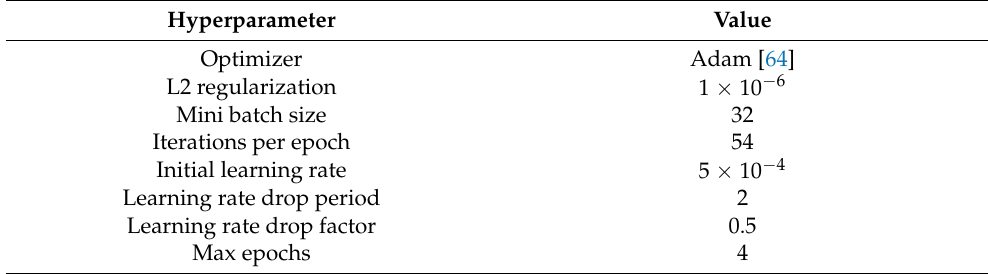
Table 2. Hyperparameters for VGGish transfer learning.